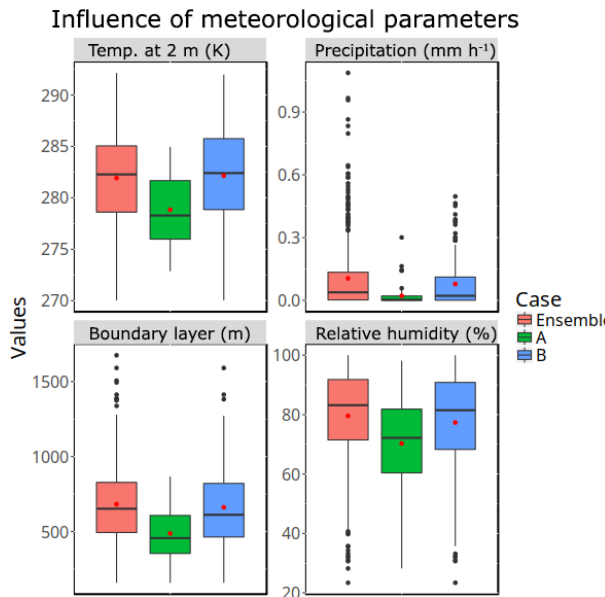
Figure 13. Statistical distributions of meteorological parameters corresponding to case A (in which both NH 3 and PM 2 . 5 pollu- tion episodes appear simultaneously, i.e. within the same day or 2d apart), case B (in which pollution episodes appear at least 3d apart), and all observations derived from 2013 to 2016. The number of observations (days) are 63 in case A, 154 in case B, and 481 for the ensemble. The medians and the quartiles are presented by cen- tre lines and borders of the boxes, respectively. The mean values are indicated by red points, and the extreme values (i.e. those beyond Q1 − 1.5 IQR and Q3 + 1.5 IQR) are indicated by black points. The IQR is the “interquartile range”, and it equals Q3 − Q1 where Q3 and Q1 are the 75th and 25th percentiles. Setting the thresholds at Q1 − 1.5 × IQR and Q3 + 1.5 × IQR is a common practice to deter- mine